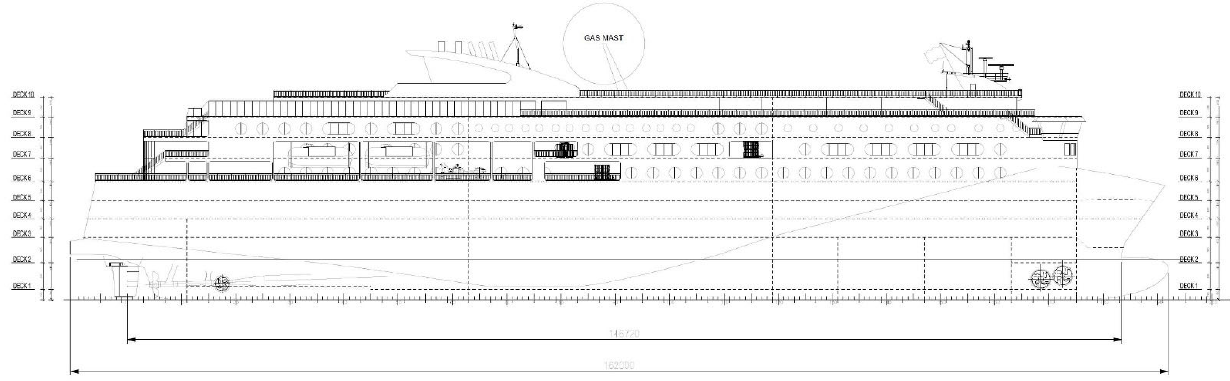
Figure 2. Side view of the MT RoPax design.